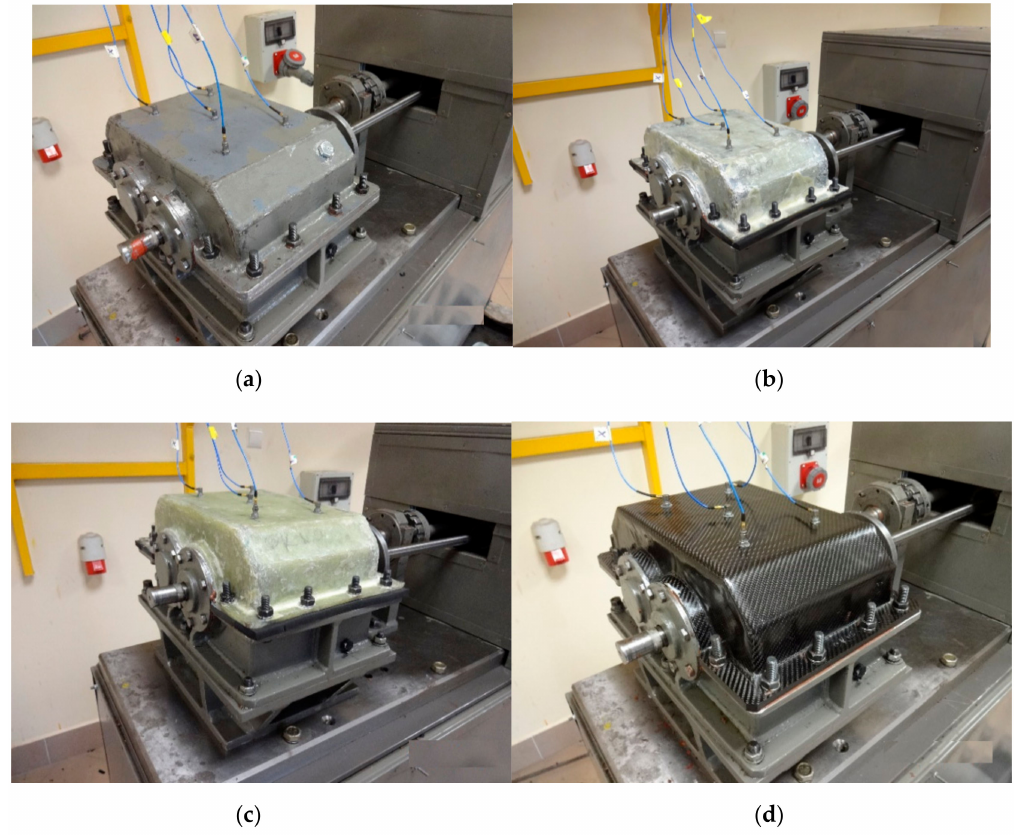
Figure 6. View of housings mounted on the stand together with measuring transducers: ( a ) Steel housing, ( b ) K_1 housing, ( c ) K_2 housing, and ( d ) K_3